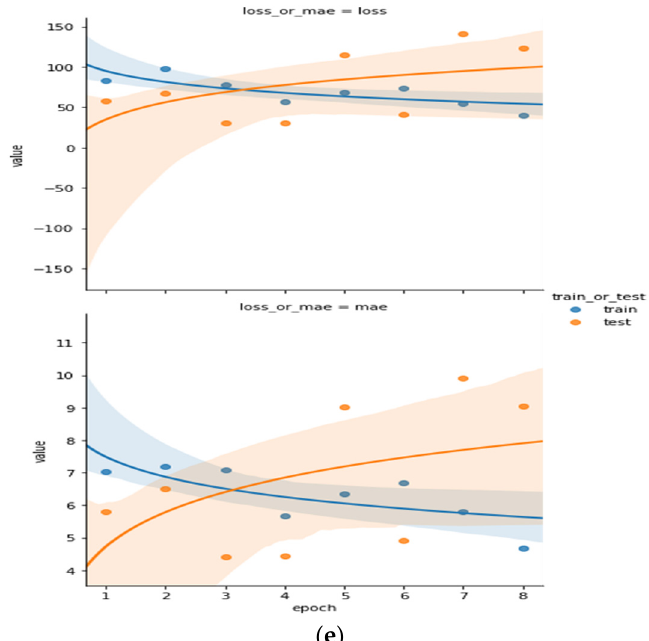
Figure 11. ( a ) One-fold validation; ( b ) two-fold validation; ( c ) three-fold validation; ( d ) four-fold validation; ( e ) five-fold validation. Table 4. RMSE values for k-fold